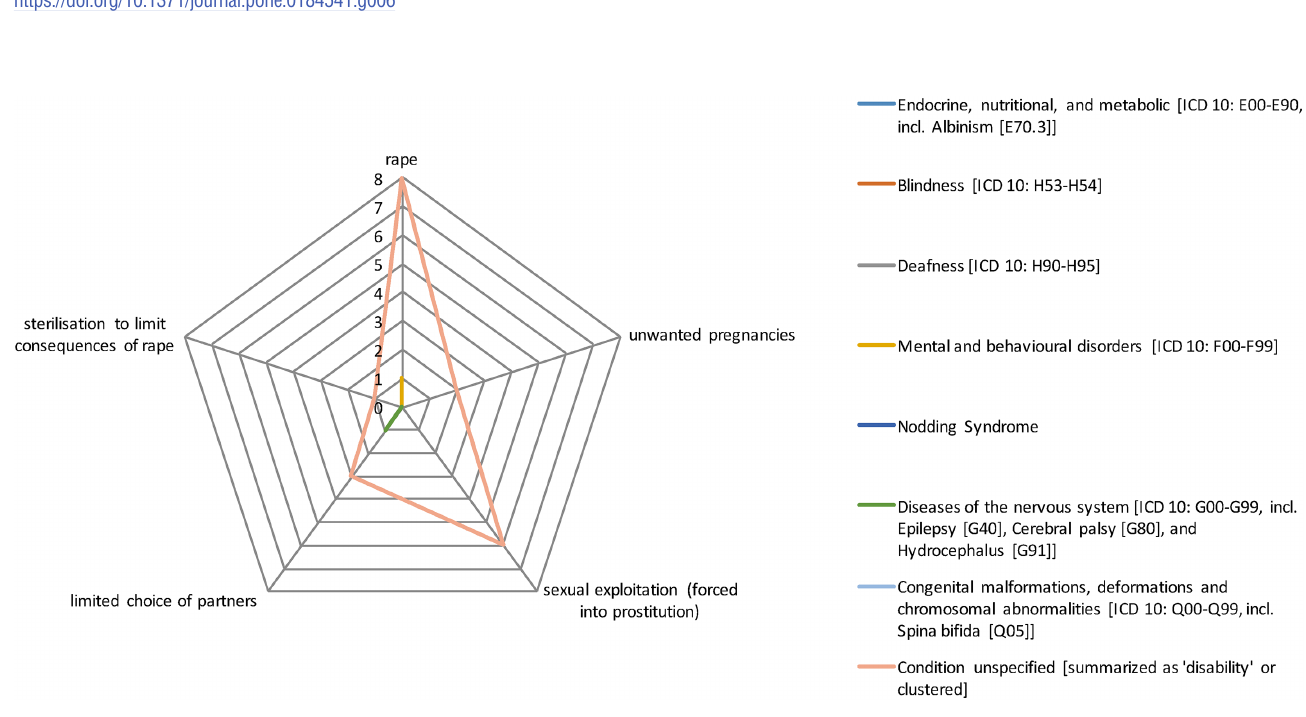
Fig 7. Evidence of sexual abuse by type of disability.